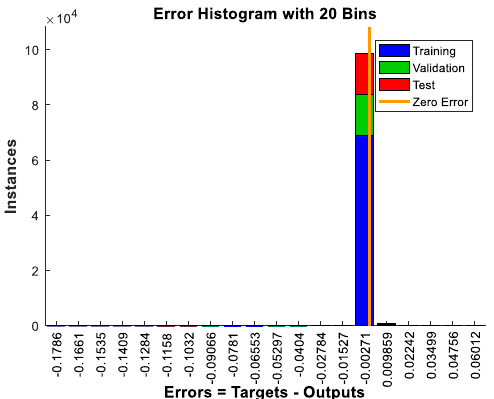
Figure 6. Distribution of the errors between the targets and the actual outputs of the network in the form of a histogram.